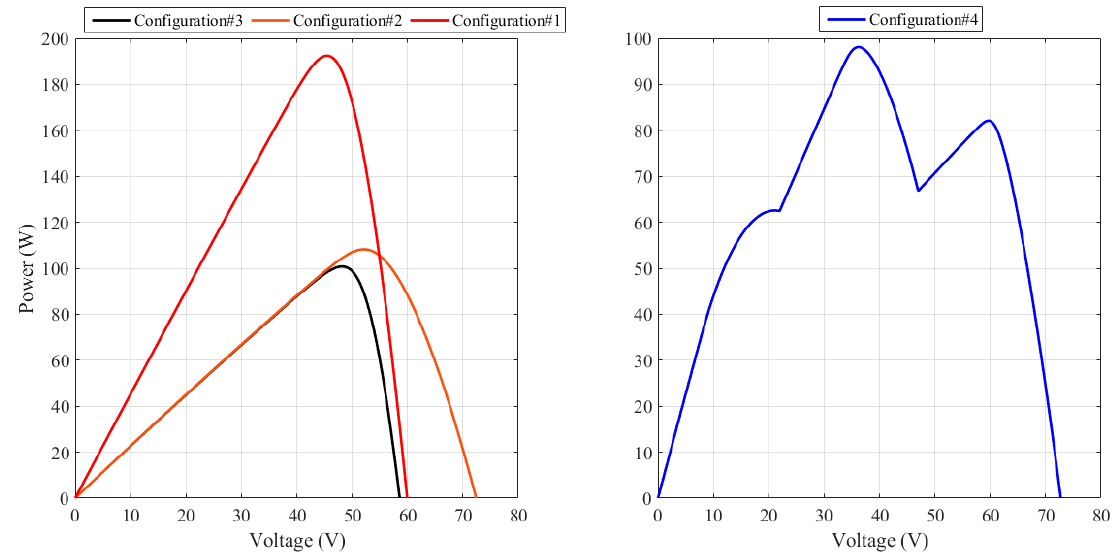
Figure 10. Power vs voltage curves of HPVTEG under different conditions. Figure 10. Power vs. voltage curves of HPVTEG under di ff erent conditions.